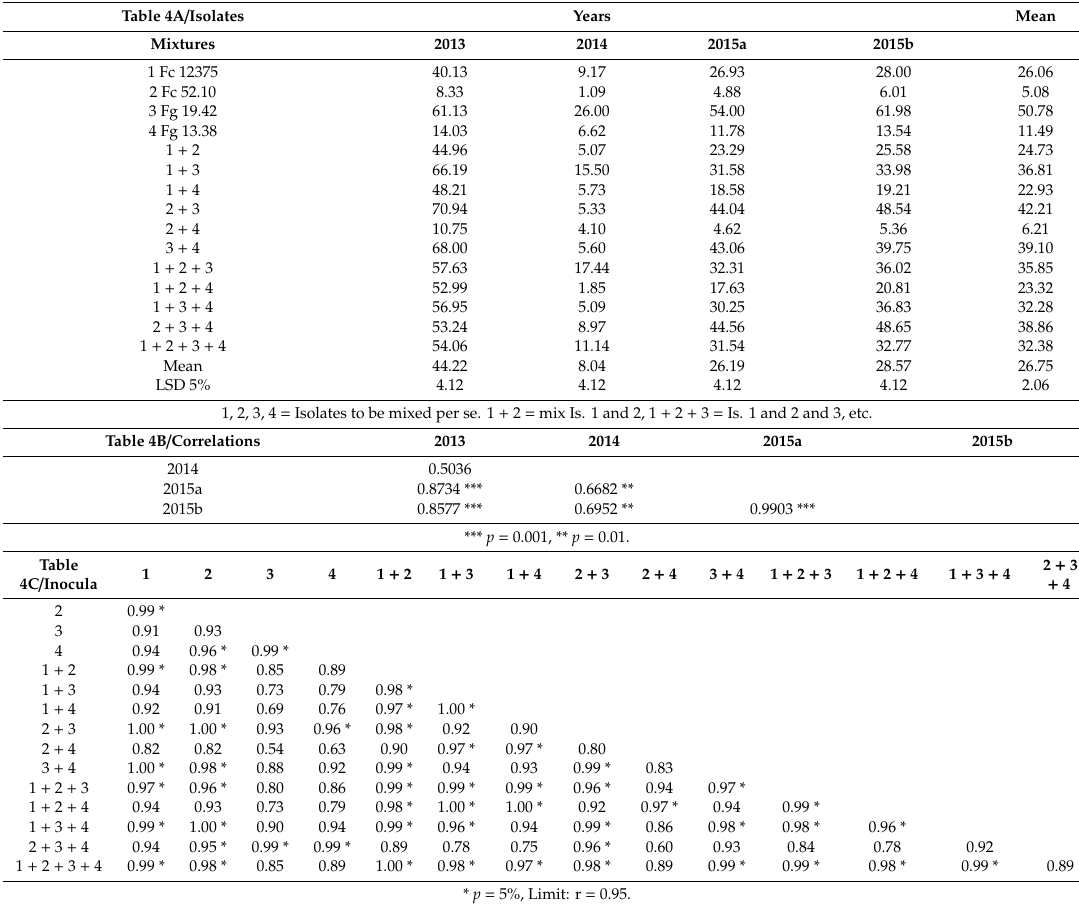
Table 4. Response during the experiments to the di ff erent isolates and their mixtures. Disease index data (%) across cultivars, Szeged, 2013–2015. Table 4A / Isolates Years Mean Mixtures